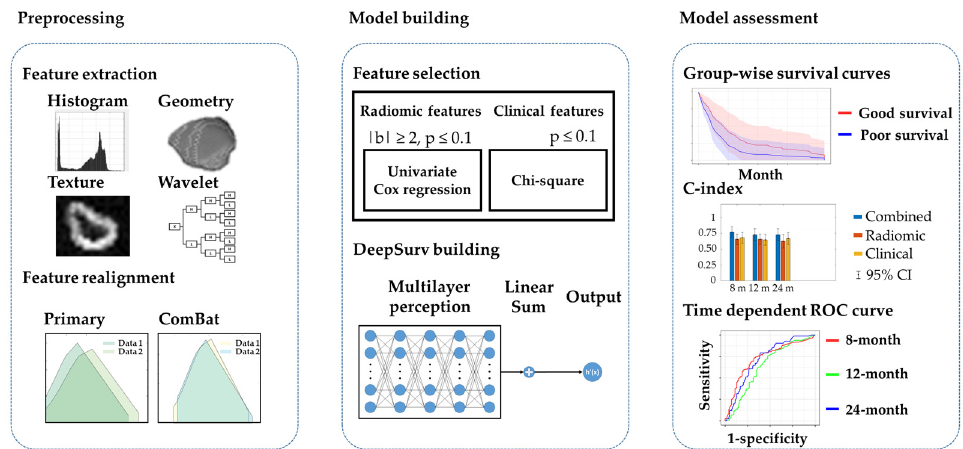
Figure 1. Workflow of the prediction model. First, radiomic features were extracted from CT images using multimodal radiomics platform. To remove the centric effect, we applied ComBat realignment on the radiomic features. Second, the dimension feature was reduced with feature selection to avoid the overfitting effect. The remained features after feature selection were applied to build a model based on DeepSurv. Finally, the assessment of model performance relied on group-wise survival curves, C-index, and time-dependent ROC curves.